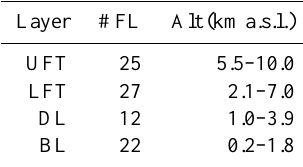
Table 3. Number of flight legs (FL) and altitude range of the layers (km) used for the classification of the horizontal flight legs.